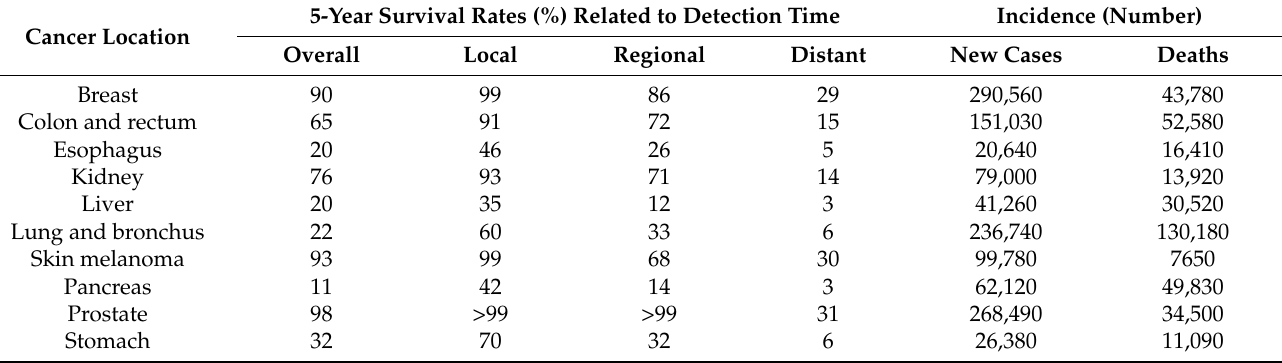
Table 1. Cancer statistical data with reference to 5-year survival rates and incidence.